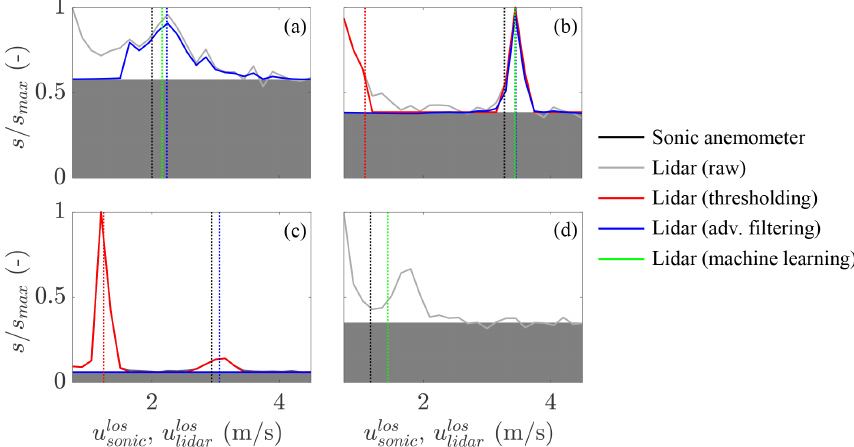
Figure 13. Selected examples of scaled lidar spectra, s/s max , where s max = 2 16 − 1, versus lidar line-of-sight velocity, u los anemometer line-of-sight velocity, u los , for inflow cases with solid interference. Solid lines ( − ) indicate spectral magnitude, and vertical sonic dashed lines (–) indicate the line-of-sight velocity estimates. See text for details. Note that the maximum value of each panel is always unity because the authors used the scaled version of the SpinnerLidar output; see Branlard et al. (2013) for context.